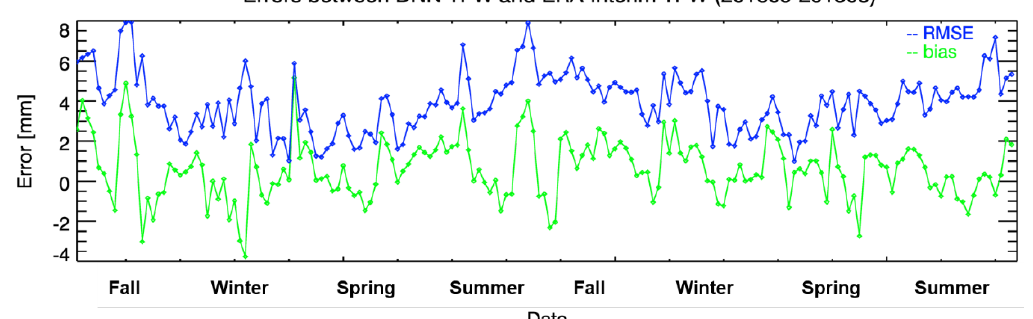
Figure 9. Time series (1st, 25th per month from September 2016 to August 2018) of bias and RMSE of the retrieved TPW from DNN for ERA-Interim TPW. The x-axis shows time and the y-axis shows the value of errors. The blue line is RMSE and the green line is bias.